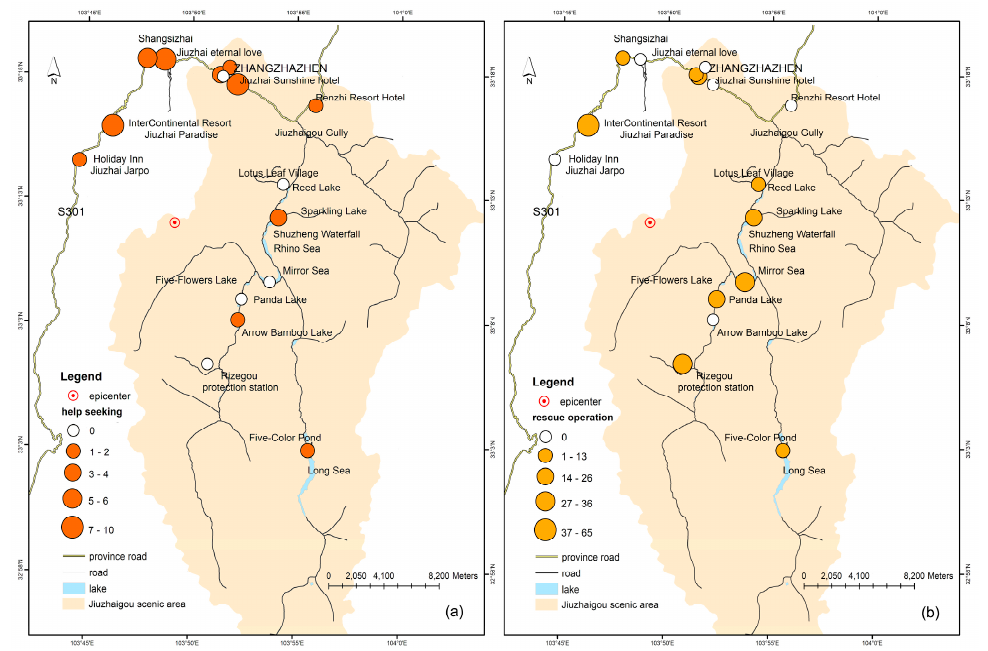
Figure 8. Spatial distribution of help-seeking ( a ) and rescue operation ( b ) microblogs. The circle size shows the number of microblogs. shows the number of